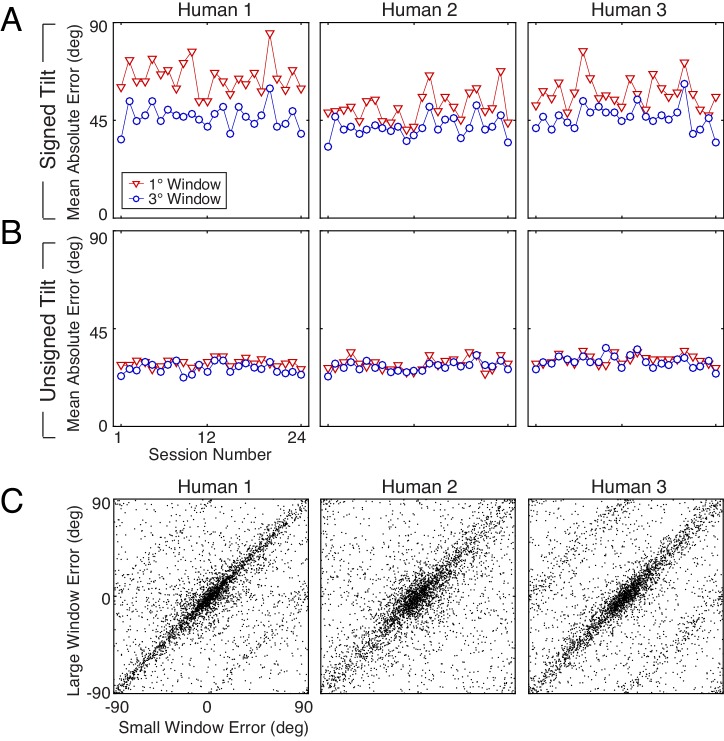
Tilt estimation errors with small vs. large apertures for natural stimuli.Signed tilt is defined in τ=[0∘,360∘) with slant in [0°,90°); unsigned tilt is defined in τ=[0°,180°) and slant in [−90°,90°). Estimation errors are analyzed in both the signed tilt and in the unsigned tilt domain. To reduce the possibility that individual stimuli were memorized, sessions with small apertures always preceded sessions with large apertures for a given set of natural stimuli. (A) Mean absolute error in the signed tilt domain across trials in each of 24 experimental sessions. The 3° aperture improves signed tilt estimation performance. With a 1° aperture, humans make significantly more sign mistakes (e.g., estimating a tilt of 45° when the groundtruth tilt is 225°). (B) Mean absolute error in the unsigned tilt domain across trials in each of 24 experimental sessions. Errors with large and small apertures in the unsigned domain are nearly indistinguishable. (C) Unsigned trial-by-trial errors with small vs. large windows for each human observer. The errors are strongly correlated, although there are several examples of 90° shifted estimates in the data of Humans 1 and 3. Overall, with unsigned tilt, performance with small and large windows was nearly equivalent.